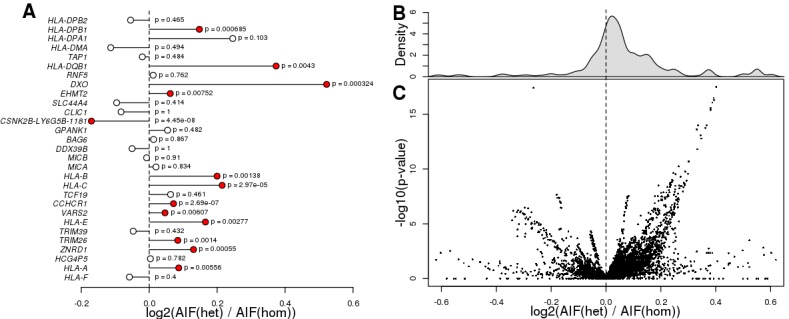
eGenes with heterozygous eQTL variants are enriched for ASE.(A) Plot showing that eGenes in samples with a heterozygous lead eQTL have larger AIF than samples homozygous for the lead eQTL. There were 29 eGenes that could be tested (i.e., with at least one heterozygous coding variant with significant AIF, at least one sample heterozygous for the lead eQTL, and at least one homozygous sample). We examined ASE (calculated as the log2 of the ratio between the mean AIF for samples heterozygous for the lead eQTL and the mean AIF for the homozygous samples) for these 29 eGenes. We observed 13 eGenes with significantly different ASE distributions, 12 of which showed stronger ASE in samples with heterozygous lead eQTLs, and one (the chimera gene CSNK2B-LY6G5B-1181) which showed stronger ASE in samples with homozygous lead eQTLs (Benjamini-Hochberg-corrected p-values<0.1, Mann-Whitney U test). (B, C) Histogram and volcano plot showing that eGenes in samples with heterozygous eQTLs (primary and conditional) had more significant AIF than in samples with homozygous eQTLs. For each of the 29 eGenes examined in panel A, we tested all associated eQTLs (there were 39,891 eQTLs in total, corresponding to 21,739 variants). Each dot in the volcano plot represents the results of one eQTL-eGene pair (each eGene had thousands of primary and conditional eQTLs). We found that for 28,841 (72.3%) of the eQTL-eGene pairs, the eGene showed significantly increased ASE in samples with heterozygous eQTLs compared with samples carrying homozygous eQTLs. P-values were calculated using Mann-Whitney U test.